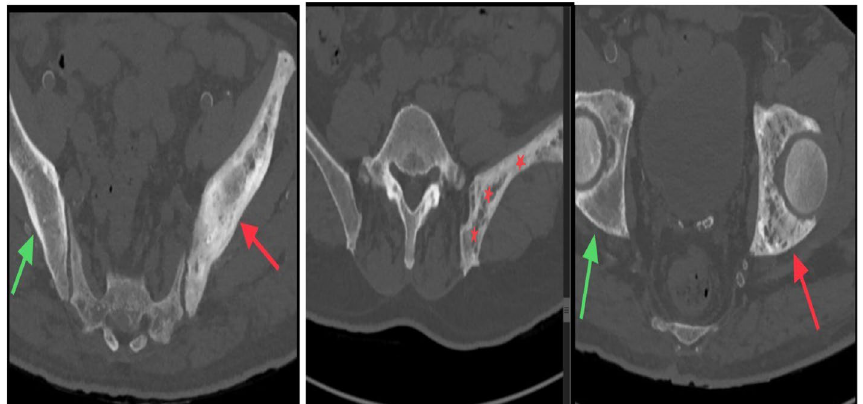
Fig. 3 Axial plane bone window MDCT redemonstrate the changes in the left ilium, ischium, and pubic bone (red arrows & stars) normal right-side bony pelvis (green arrow)